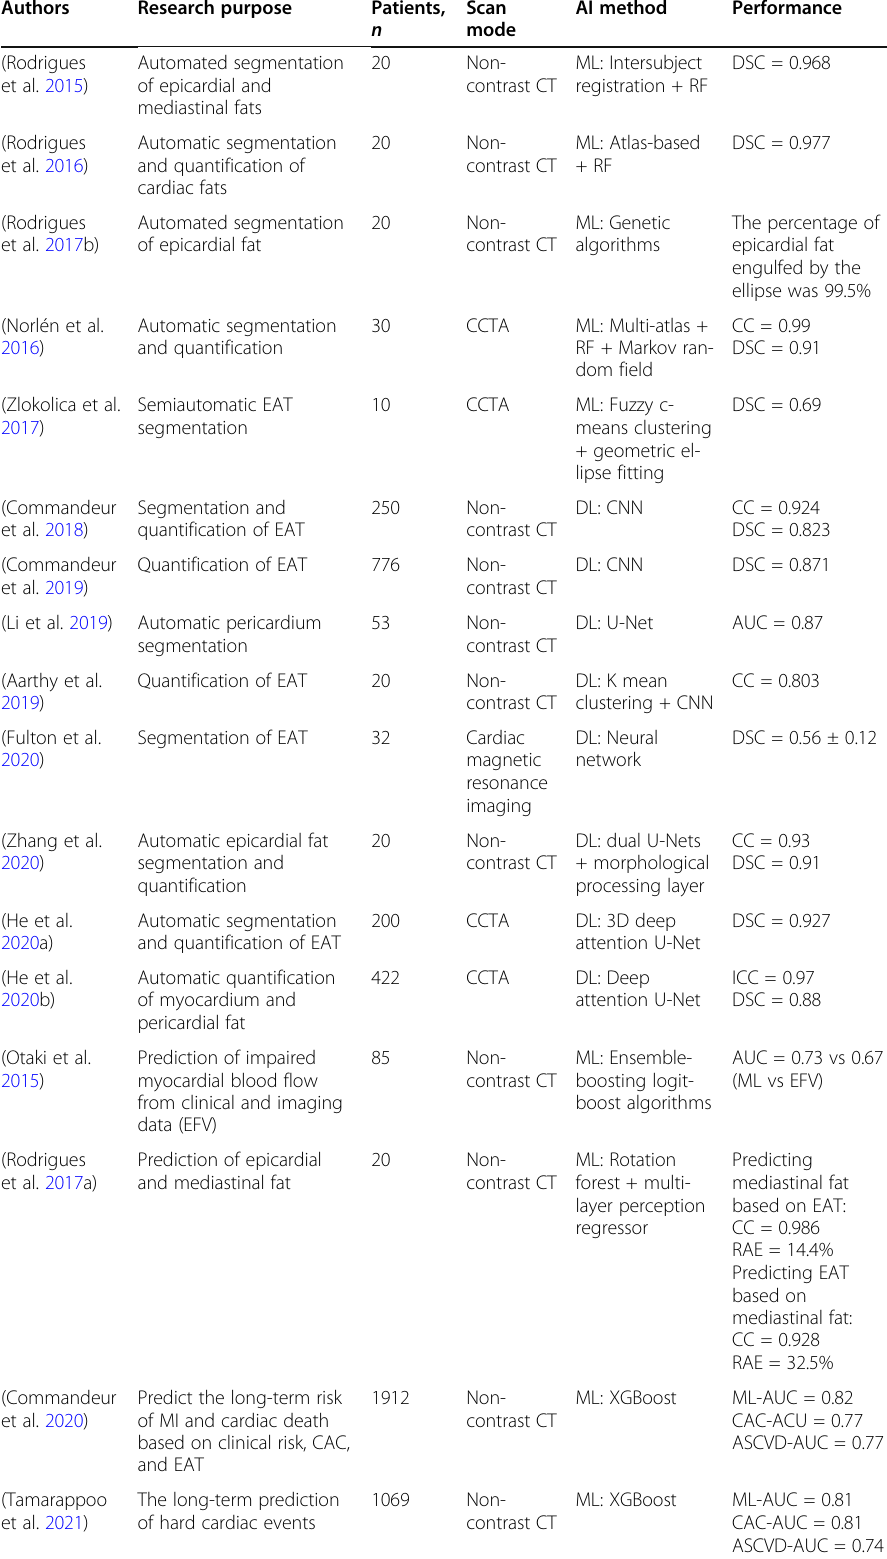
Table 1 Characteristics of studies included in the systematic